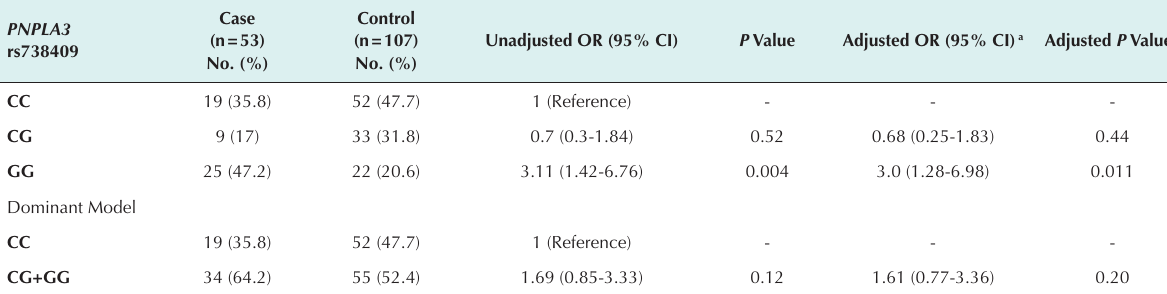
Table 2. Distribution of Genotypes in Case and Control Groups PNPLA3 rs738409